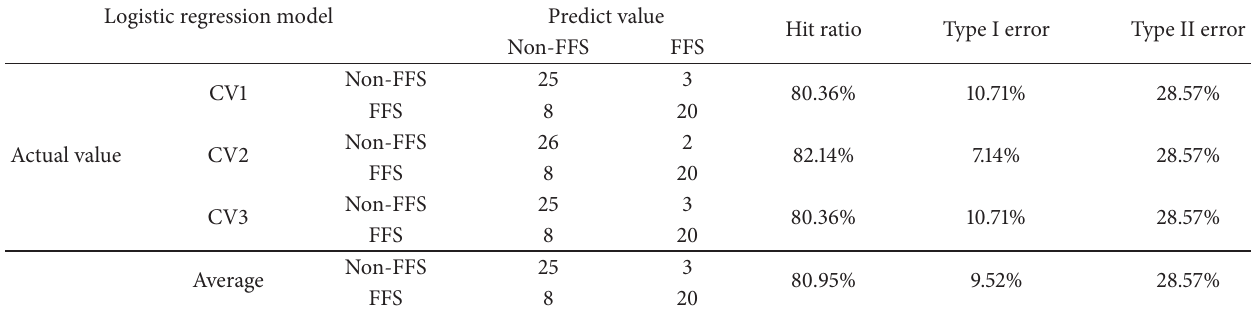
Table 4: Logistic regression cross-validation